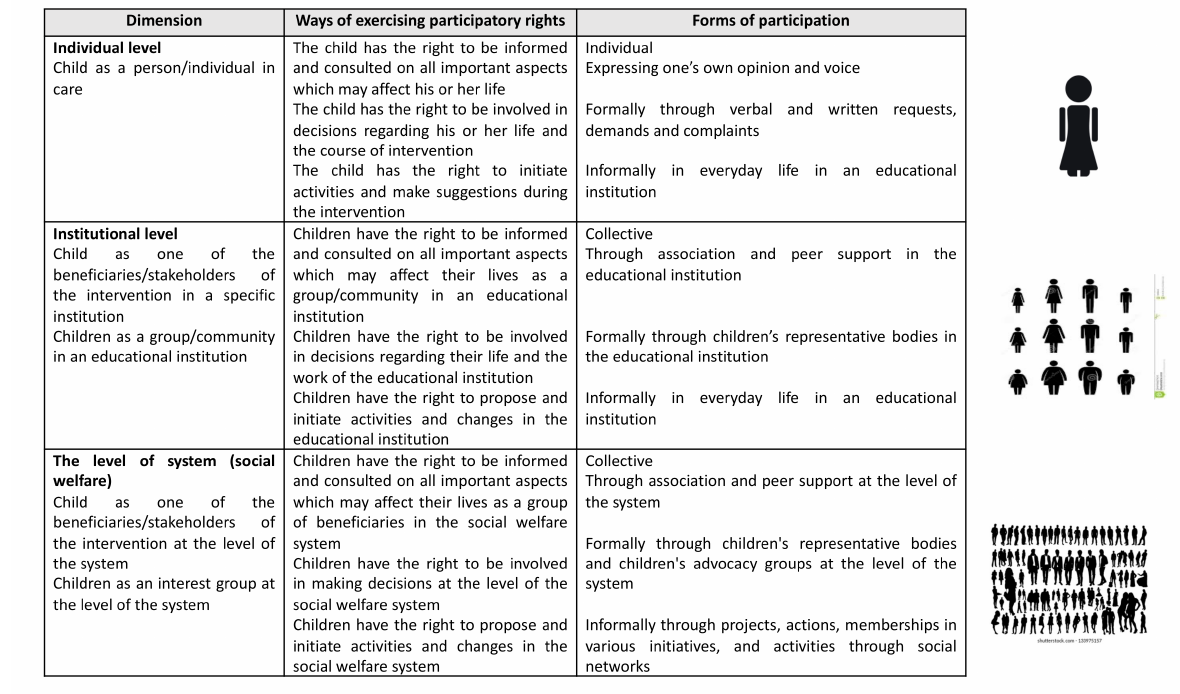
Figure 1. Dimensions of child participation in residential